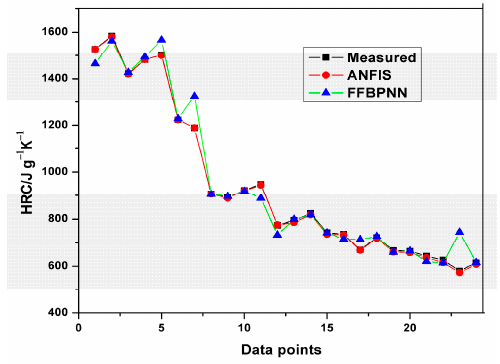
Figure 12. Comparison of HRC training results.